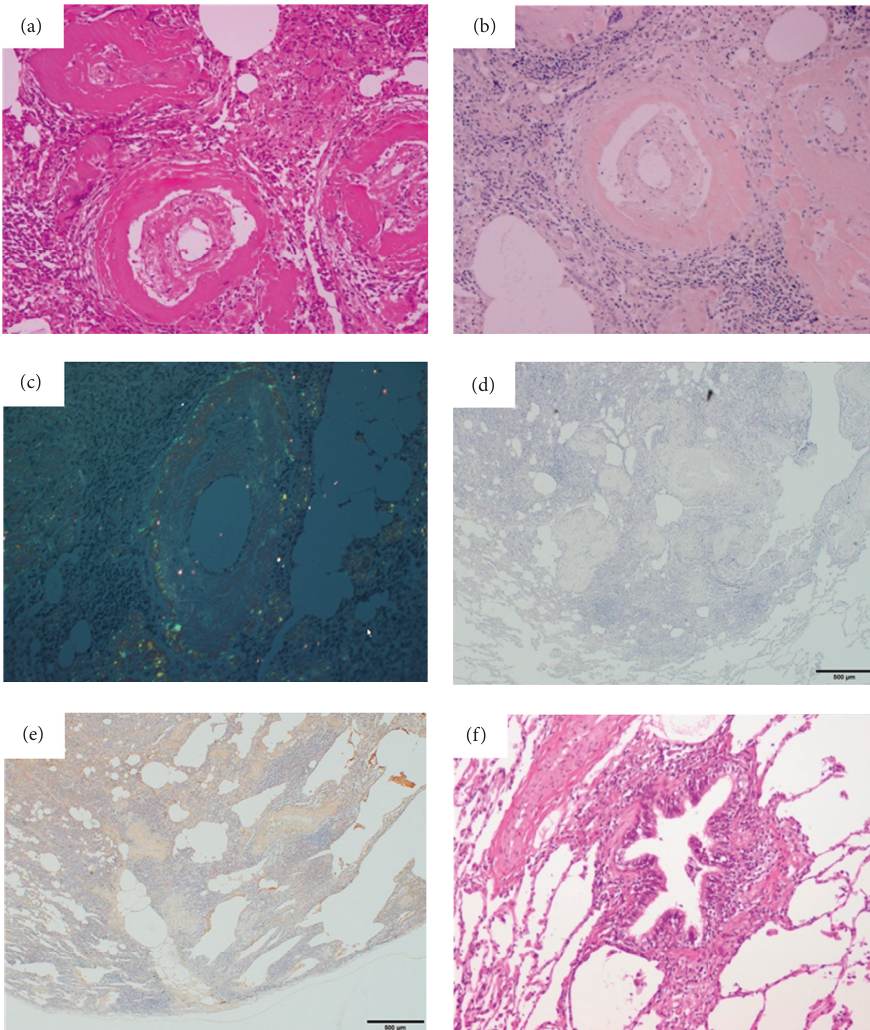
Figure 2: Pathologic findings of the surgical lung biopsy in a 72-year-old woman with Sj¨ogren syndrome and pulmonary amyloidosis. (a) There is a homogeneous eosinophilic material in the vascular area (hematoxylin and eosin stain, × 100), which (b) was positive on Congo red stain ( × 100). (c) Polarizing microscopy shows apple green birefringence ( × 100). (d) The immunohistochemical staining with AA amyloid ( × 100) was negative. (e) The immunohistochemical staining with AL-kappa amyloid ( × 100) was positively stained. (f) There is infiltration of inflammatory cells in the peribronchial areas (hematoxylin and eosin stain, ×